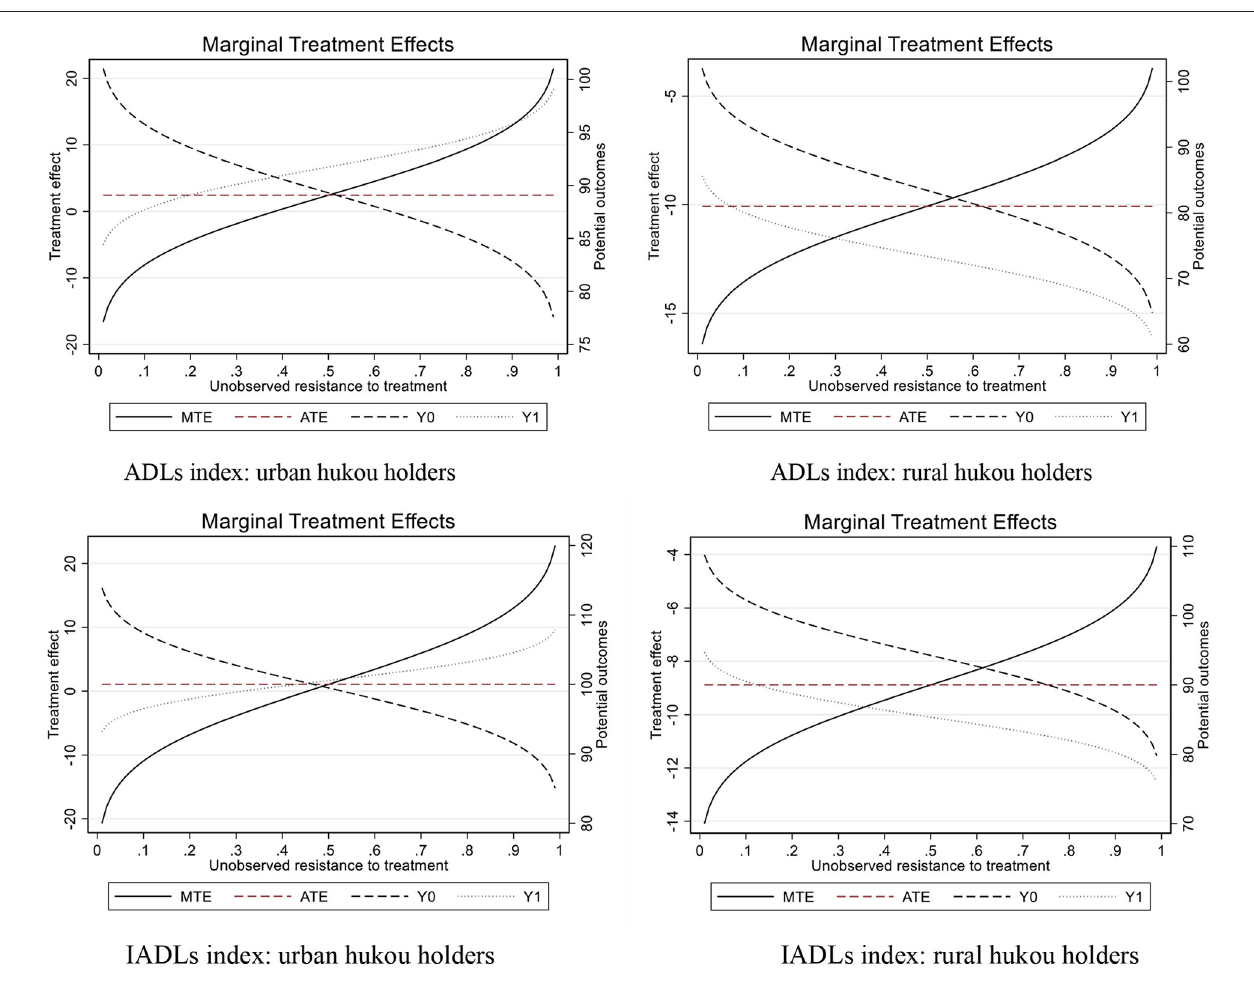
FIGURE 3 | The resulting potential outcomes from